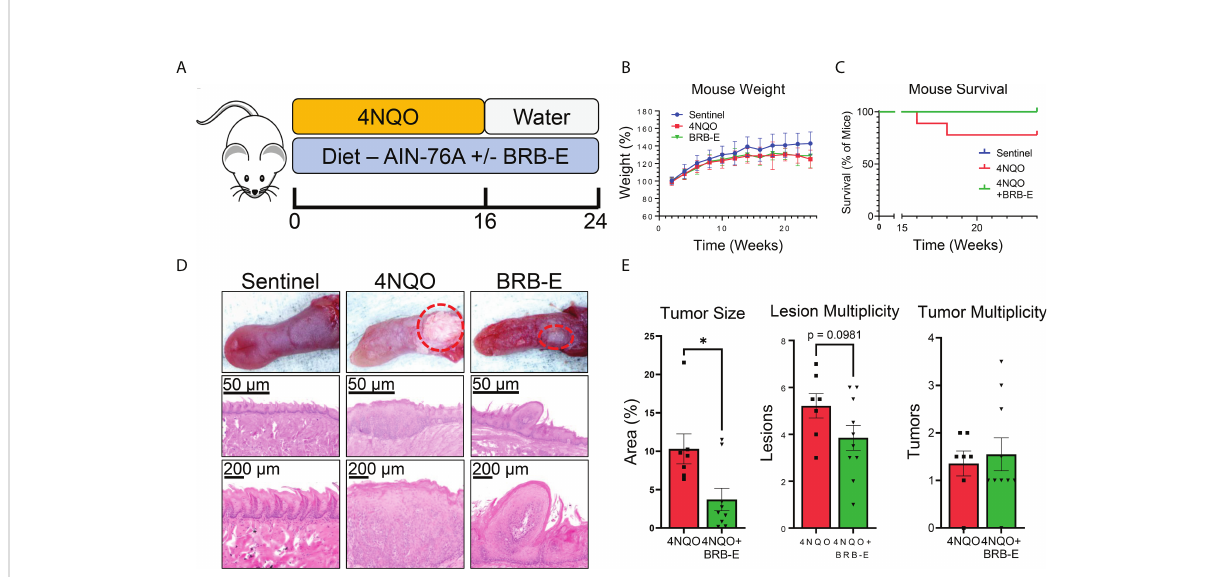
(Figure 2A). Our fl ow cytometric analysis of the total T-cell populations revealed no signi fi cant difference in CD4 + or CD8 + T-cell populations between carcinogen-induced and